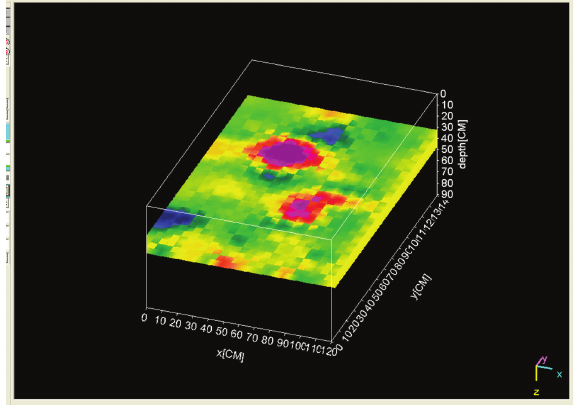
Figure 3: Constant depth at the depth of about 40cm, achieved from